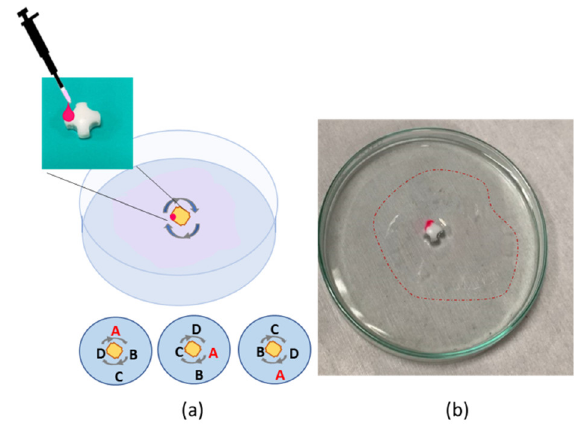
Figure 4. ( a ) Outline of the experiment: the white magnet commonly used for stirring is activated by the dispensing of polymer droplet, and the rotation of the magnet induces the film formation. ( b ) The polymeric film formed on the fly is indicated by the dotted line.